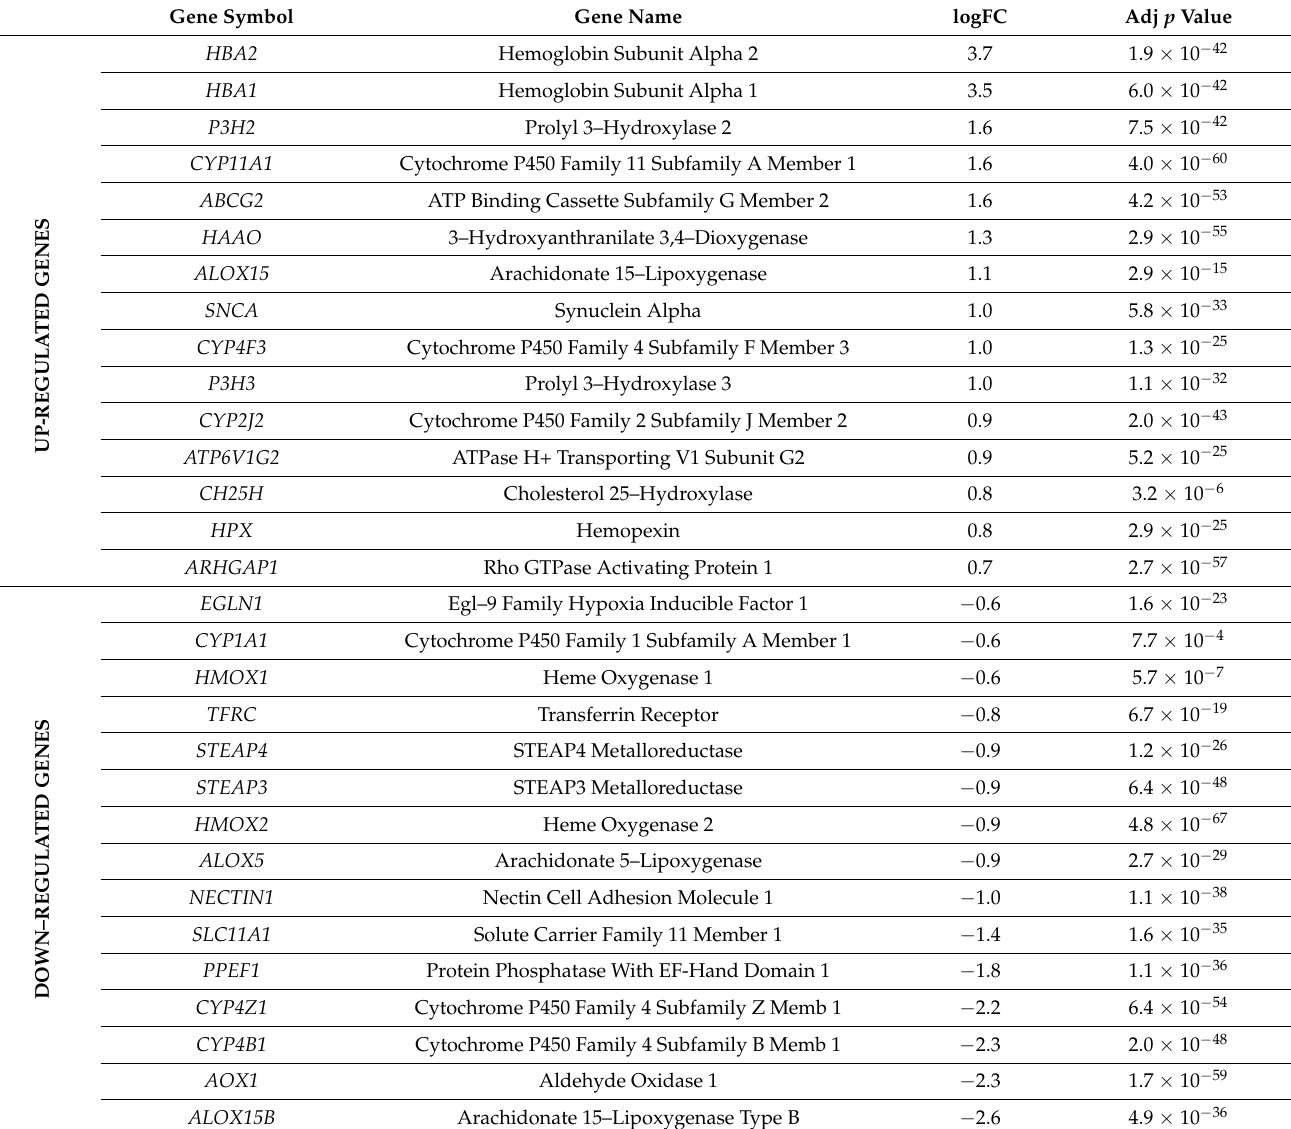
Table 1. Top 15 up- and down-regulated iron-linked genes obtained from bulk RNA-seq analysis in DCM compared to NF